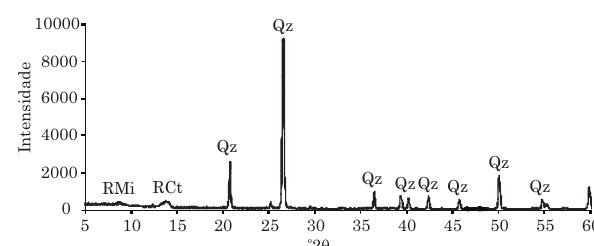
Figura 1. Difratograma de raios-X (radiação Cu K ααααα ) da fração areia do horizonte A1 do perfil 1. Qz: quartzo, RMi: resíduo de mica, e RCt: resíduo de caulinita.